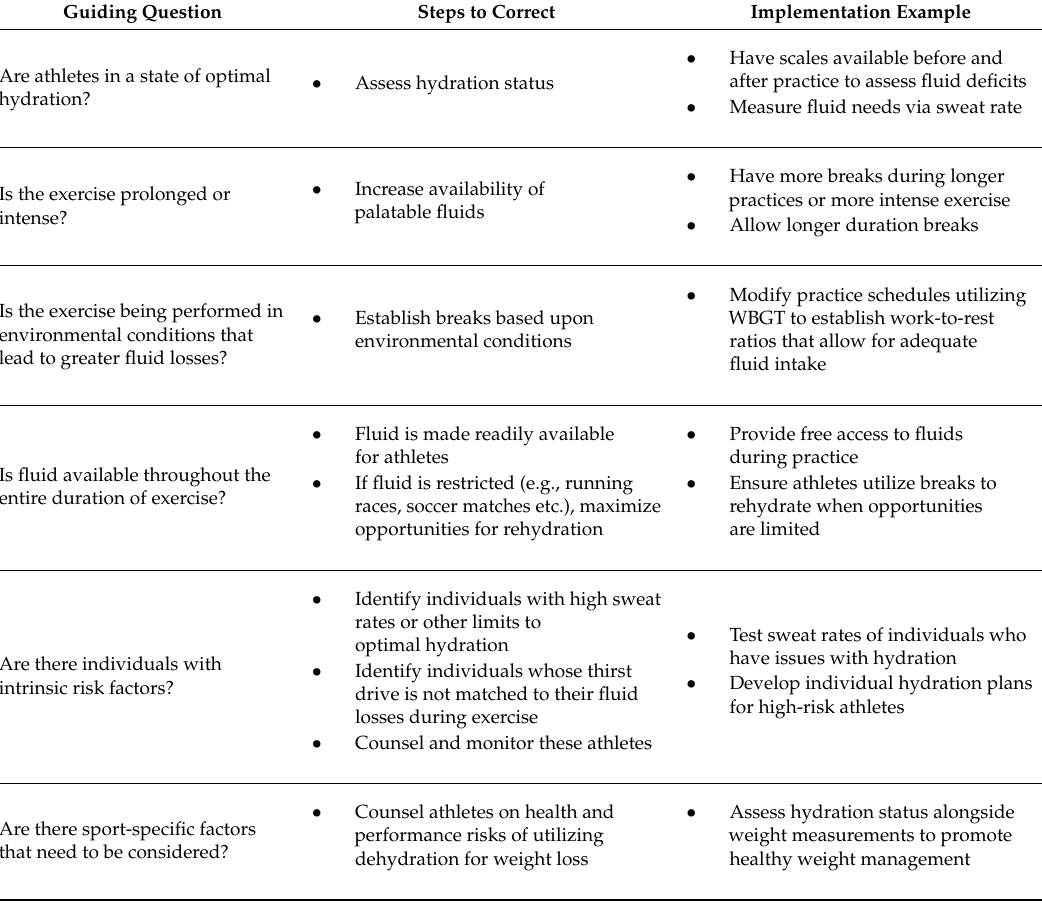
Table 3. Establishing a Hydration